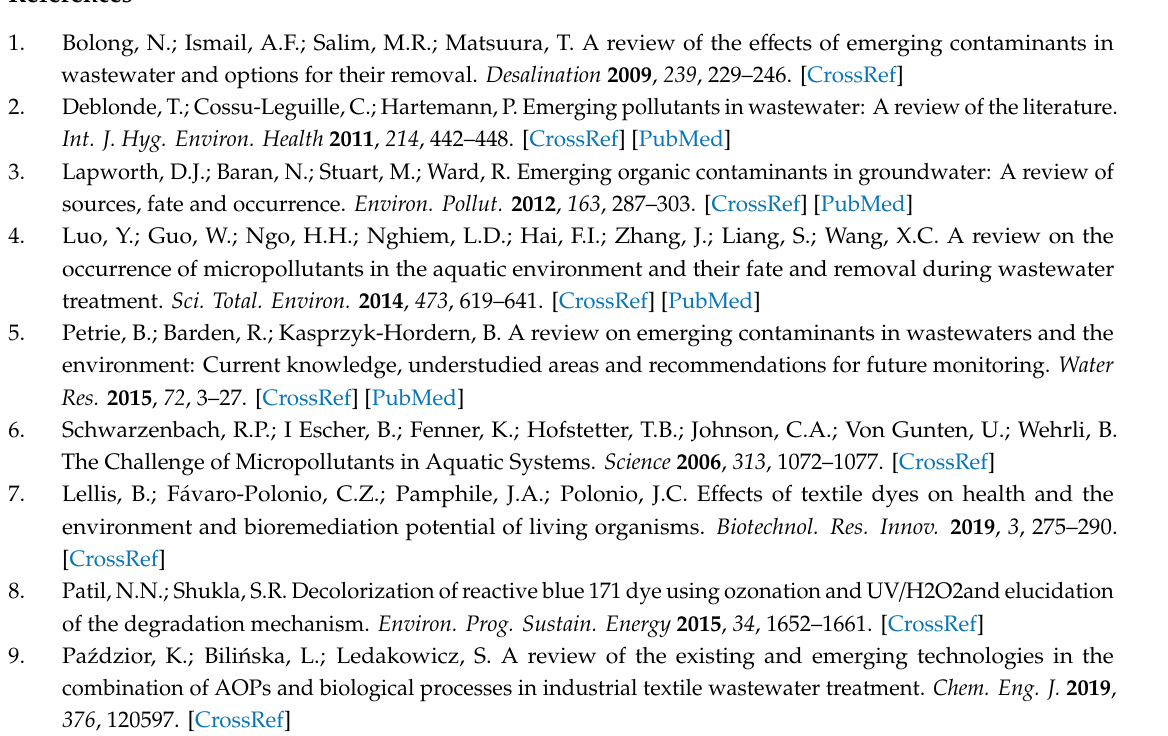
Figure S1: Color removal during subsequent catalytic ozonation cycles using the same AC (0.5 g / L); RB5 model solution (0.5 g / L); reaction time 30